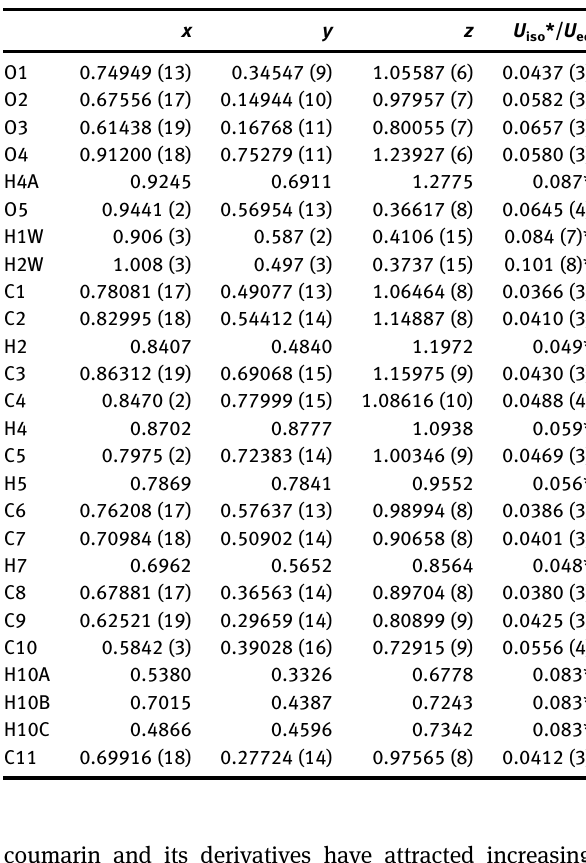
Table  : Fractional atomic coordinates and isotropic or equivalent isotropic displacement parameters (Å 